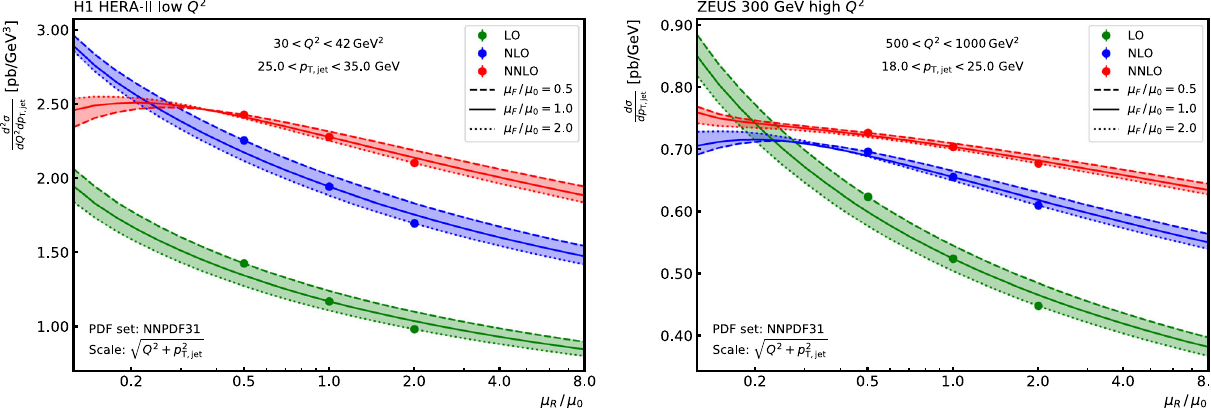
Fig. 3 The scale dependence for a single bin in jet p T with 25 < p T , jet < 35GeV for a range 30 < Q 2 < 42GeV 2 from H1 (left) and in jet p T with 18 < p T , jet < 25GeV for a range 500 < Q 2 < 1000GeV 2 from ZEUS (right). The bands show the result of varying the factorisa-